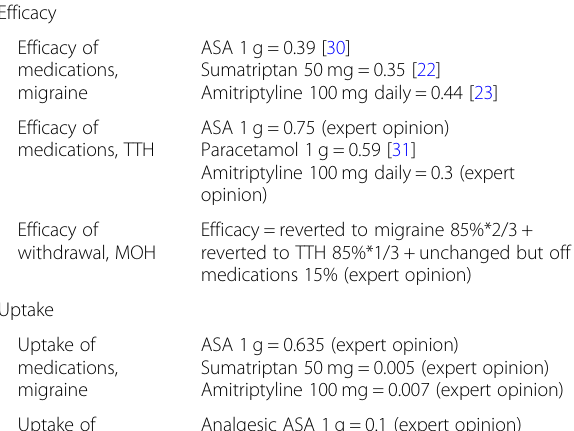
Table 5 Assumptions adopted when calculating the health effects Efficacy Efficacy of